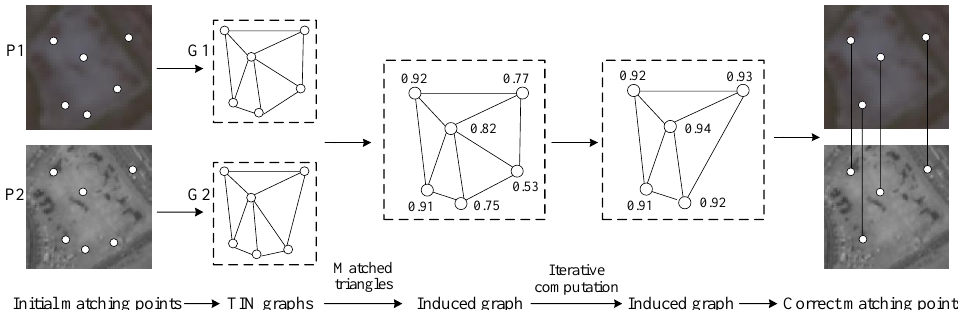
Figure 2. The workflow of triangular irregular network (TIN) graph.